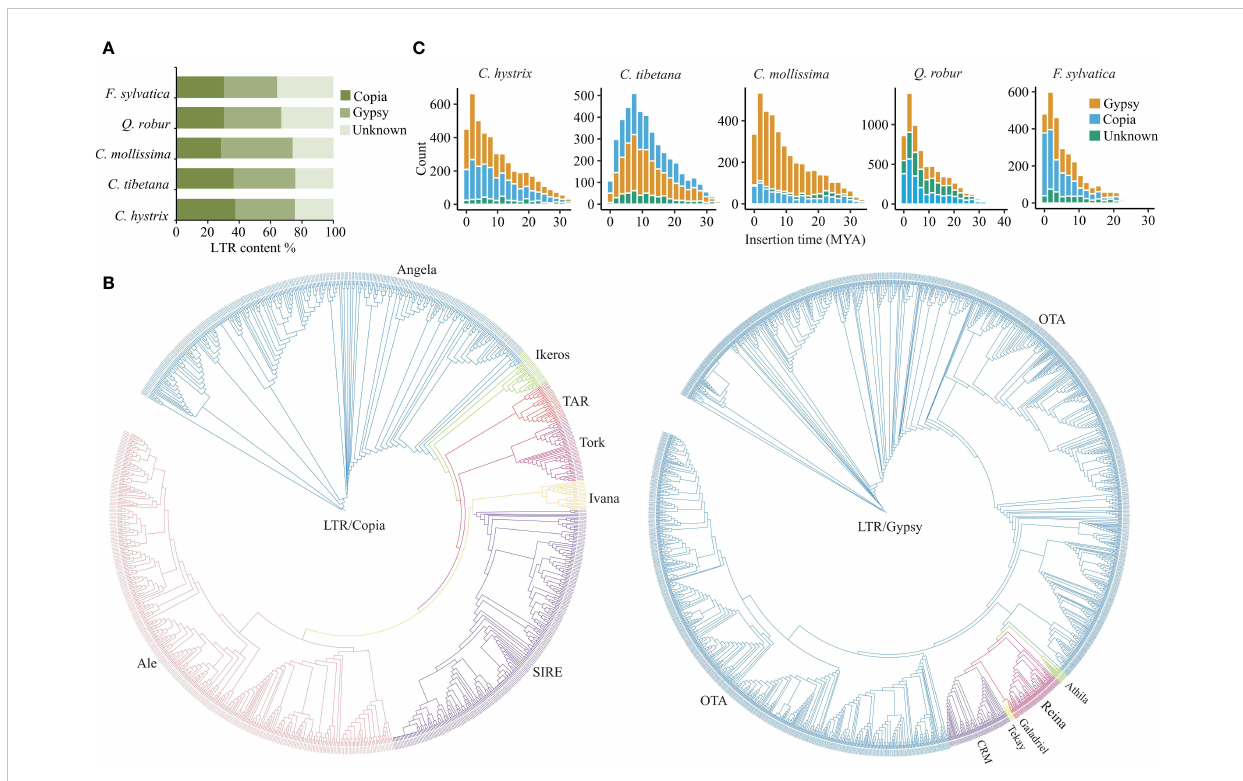
FIGURE 3 The features of LTR expansion in the Fagaceae genomes. (A) Comparison of LTR contents in C hystrix and 4 other species. (B) Neighbor-joining trees of Copia and Gypsy LTRs from C hystrix . (C) Insertion time estimates of full-length LTRs in fi ve Fagaceae